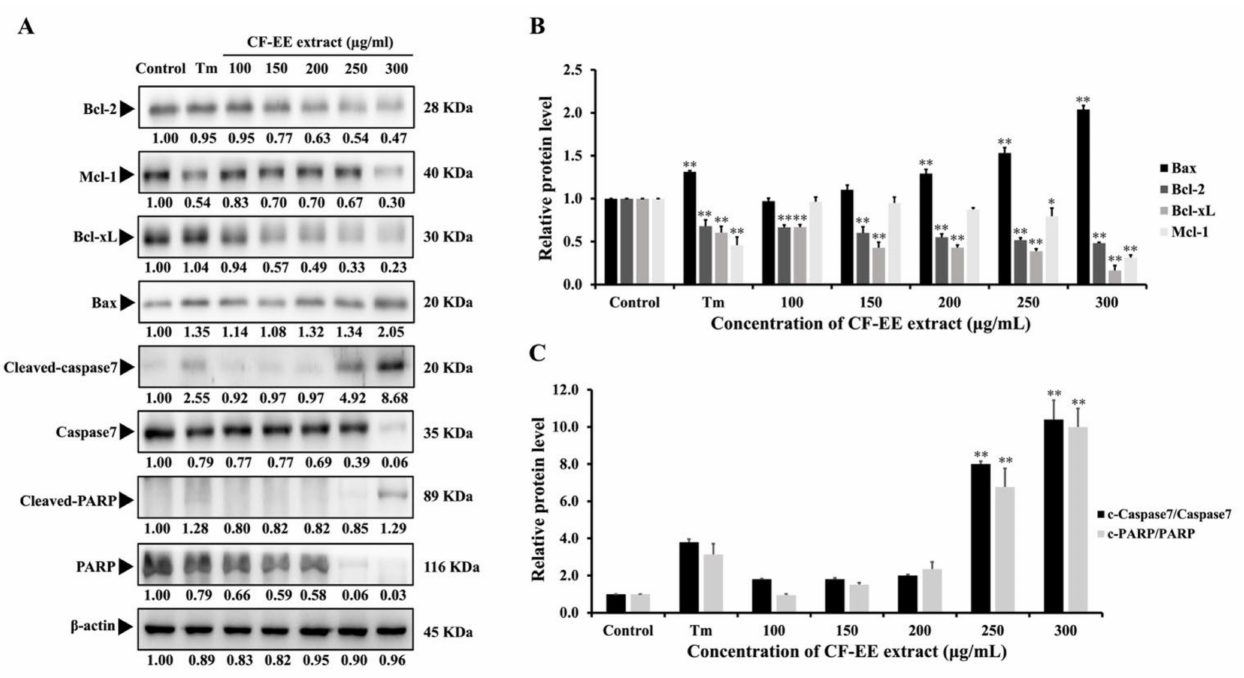
Figure 7. Effect of CF-EE extract on apoptosis pathway in HeLa cells. The cells were treated with CF-EE extract at various concentrations or 10 µ g/mL of Tm for 24 h. The protein expressions were investigated by Western blotting. ( A ) Decreased Bcl-2, Bcl-xL, Mcl-1, and increased Bax, cleaved- caspase-7/caspase-7, and cleaved-PARP/PARP were detected. ( B , C ) Relative protein band intensity, β -actin was used as an internal control. The values are represented as the mean ± SD. * p < 0.05 and ** p < 0.01 compared to the